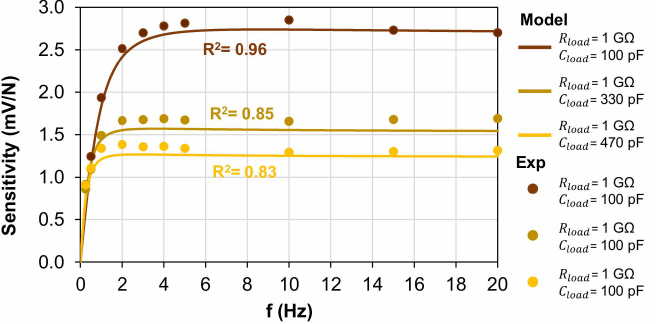
Figure 11. Sensitivity of the piezoelectric sensor vs. frequency of the compressive force for R load = 1 G Ω and different values of C load .